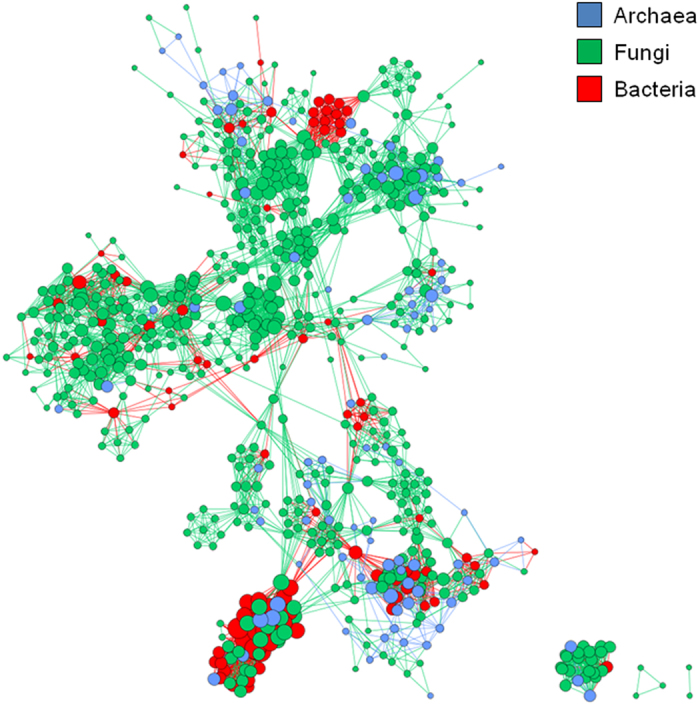
Co-occurrence network of the main OTUs based on correlation analysis.Nodes correspond to microbial OTUs and edges to the microbial associations. A connection stands for a strong (Spearman’s ρ > 0.6) and highly significant (P < 0.001) correlation. The size of each node is proportional to the number of degree.